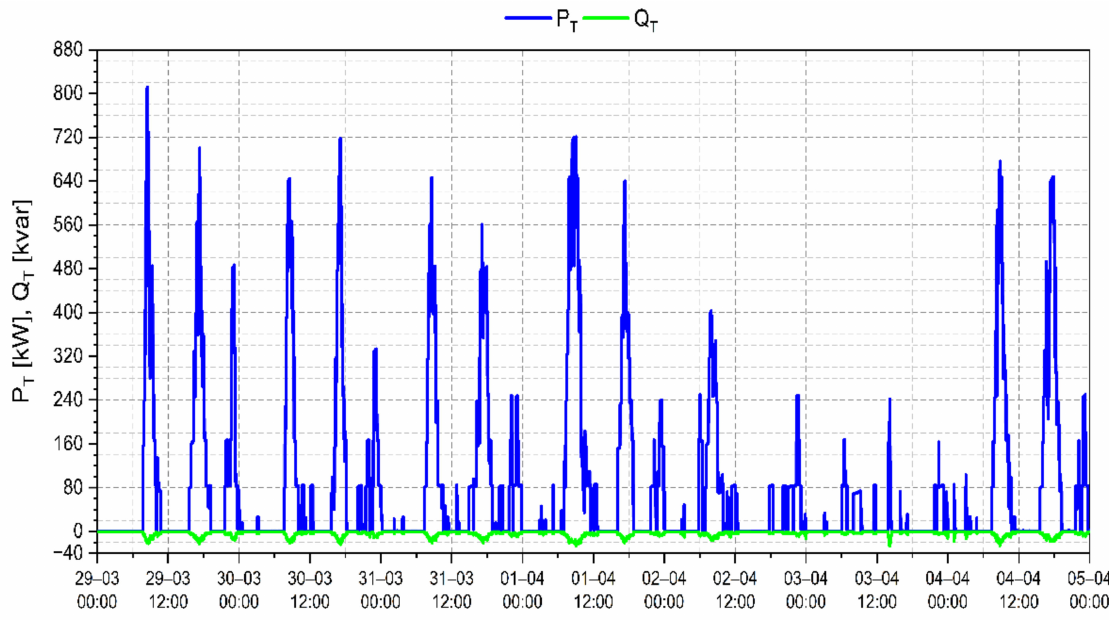
Figure 3. Weekly total active and reactive power demand profile (data aggregation interval: 150